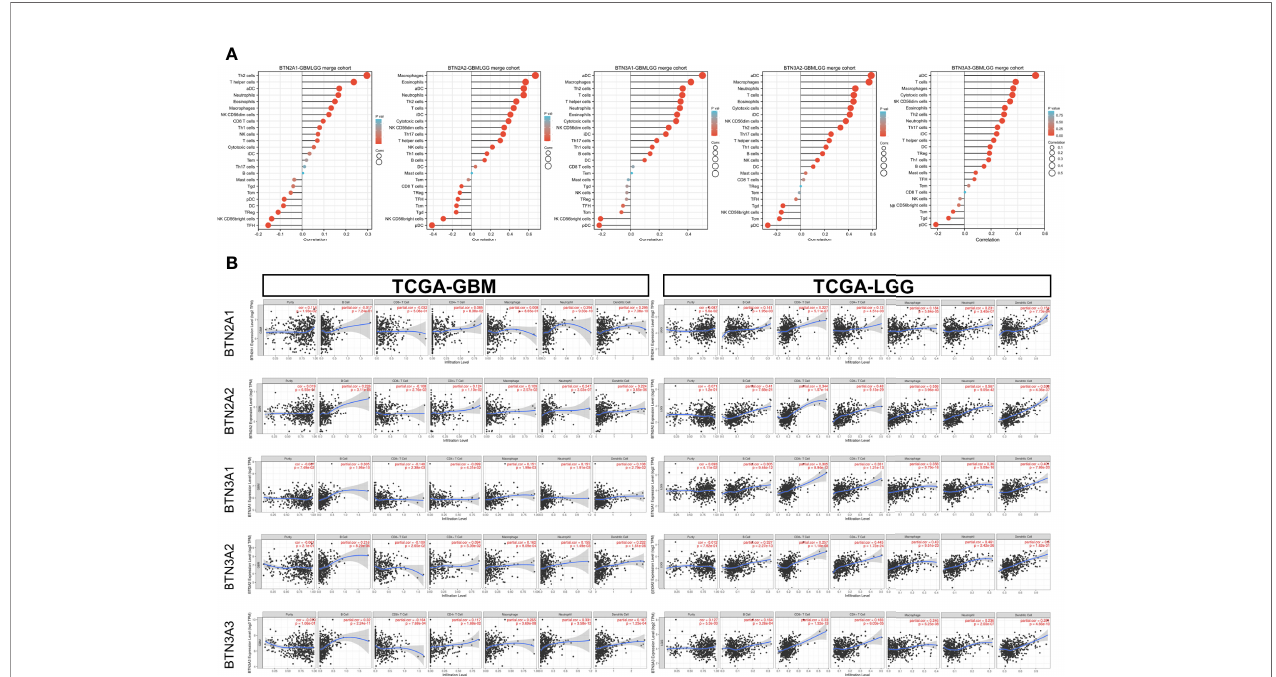
FIGURE 6 | Correlation of BTN2/3 subfamily expression with immune in fi ltration levels in pan-glioma. (A) Level 3 HTseq-FPKM format RNA-seq data and clinical data in TCGA-GBMLGG dataset analyzed by GSVA – ssGSEA immune in fi ltration analysis. The abbreviations and corresponding names of the 24 immune cells are as follows: aDC, activated DC; B cells; CD8 T cells; cytotoxic cells; DC; eosinophils; iDC, immature DC; macrophages; mast cells; neutrophils; NK CD56bright cells; NK CD56dim cells; NK cells; pDC, plasmacytoid DC; T cells; T helper cells; Tcm, T central memory; Tem, T effector memory; Tfh, T follicular helper; Tgd, T gamma delta; Th1 cells; Th17 cells; Th2 cells; Treg. (B) Correlation between BTN2/3 subfamily expression and tumor-in fi ltrating lymphocytes in pan-glioma by TIMER. TCGA- GBMLGG, The Cancer Genome Atlas – glioblastoma and low-grade glioma; GSVA, gene set variation analysis; ssGSEA, single-sample gene set enrichment